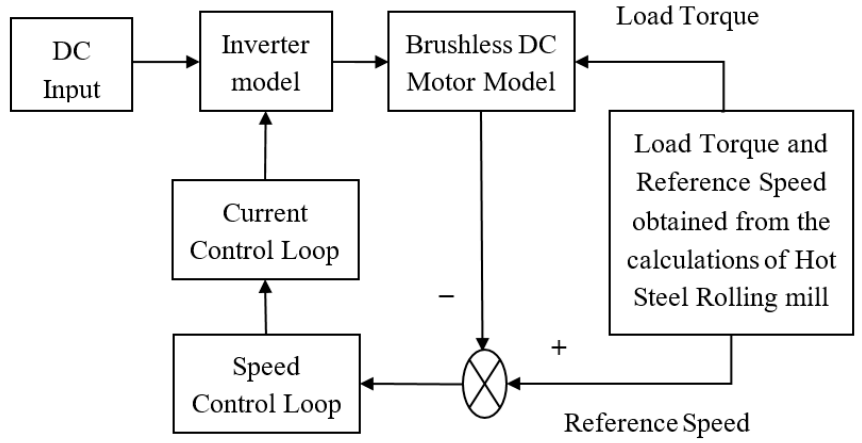
Figure 4. The entire closed loop system in Simulink.